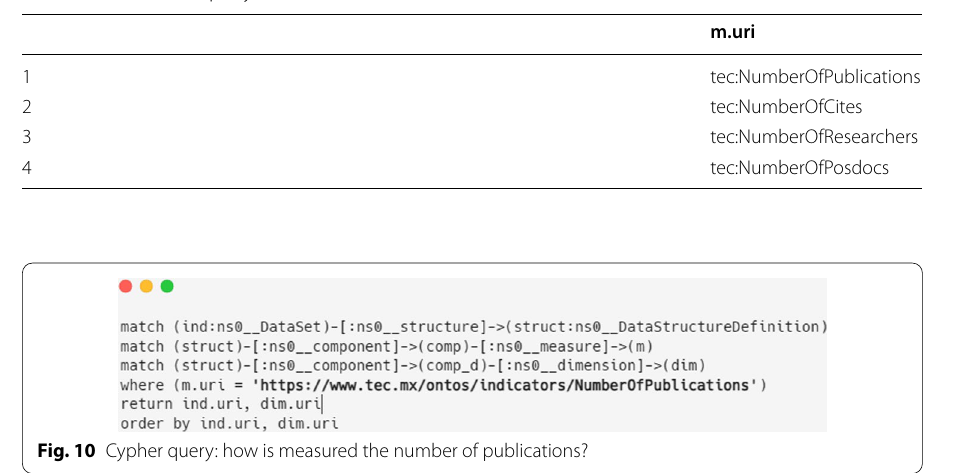
Table 3 Results for query: what is measured?